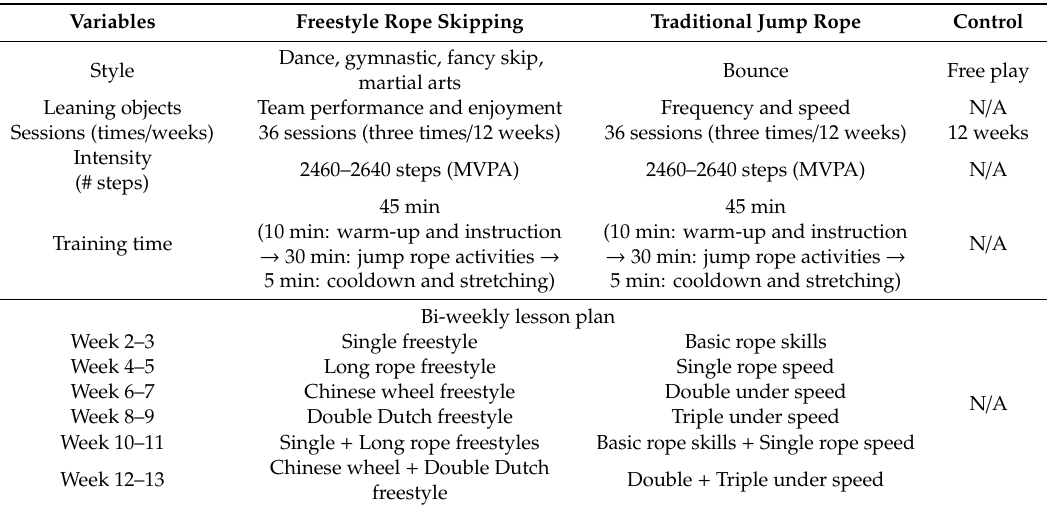
Table 1. The summary of the intervention